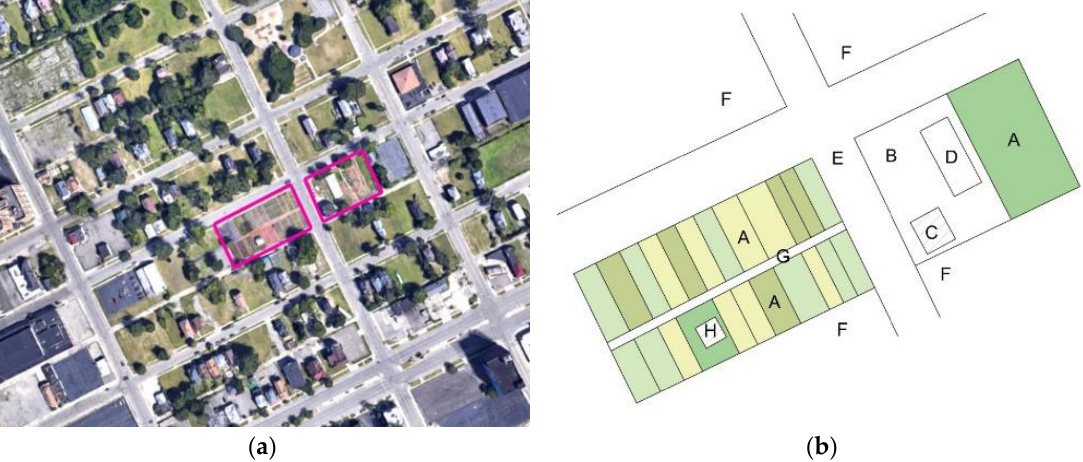
Figure 7. MUFI (Detroit): ( a ) Location of the MUFI farm in Detroit [original study, based on: www.google.pl/maps, (accessed on 16 August 2018)], ( b ) Scheme of the MUFI farm. Explanation: A — crop beds, B — MUFI lot, C — MUFI headquarters (a vacant property), D — crops in a foil tunnel, E — road, F — housing lots, G — path, H — crops in a foil tunnel.